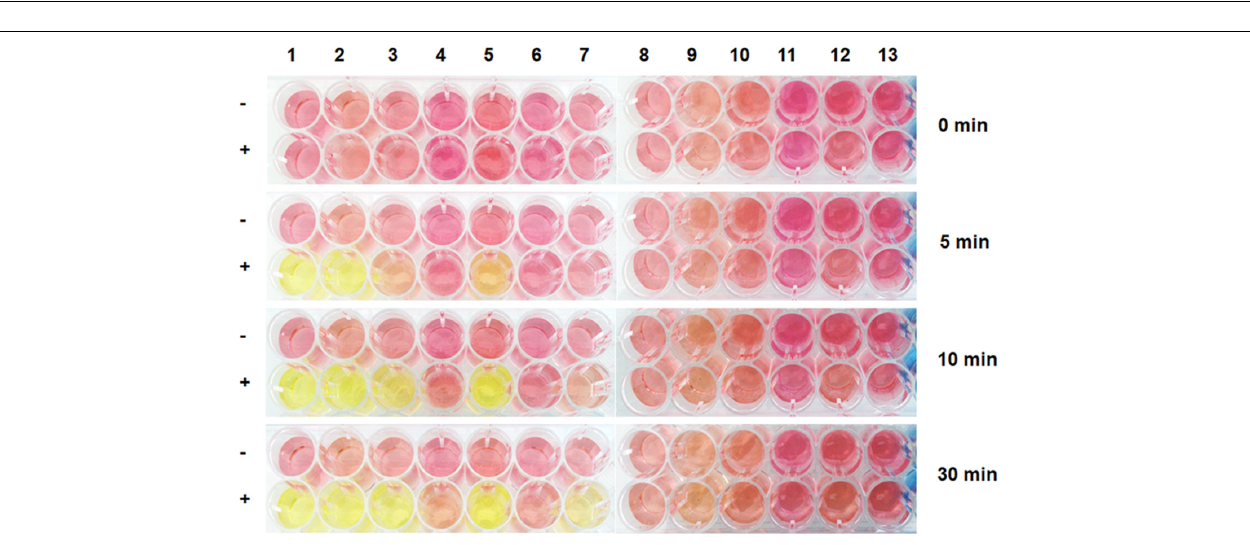
FIGURE 2 | Screening of ZgHAD specificity toward different halogenated substrates based on colorimetric assays. Pictures were taken after 0, 5, 10 and 30 min of enzymatic reaction. Substrates are: (1) iodoacetic acid; (2) bromoacetic acid; (3) chloroacetic acid; (4) D-2-bromopropionic acid; (5) L-2-bromopropionic acid; (6) D-2-chloropropionic acid; (7) L-2-chloropropionic acid; (8) trichloroacetic acid; (9) 3-iodopropionic acid; (10) 3-bromopropionic acid; (11) 2-chlorobutyric acid; (12) iodoacetamide; (13) dibromoacetic acid; (-) no enzyme; (+) with